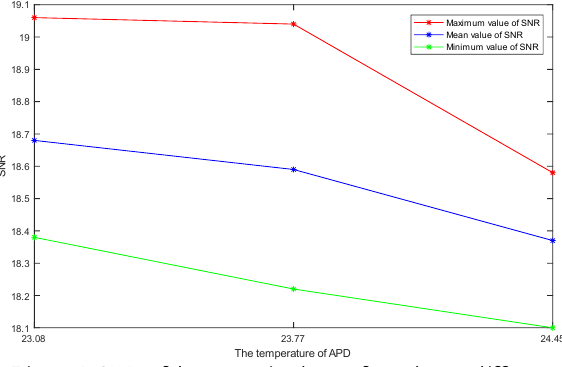
Figure 4. SNR of the transmitted waveform data at different APD temperatures (taking laser-2 as an